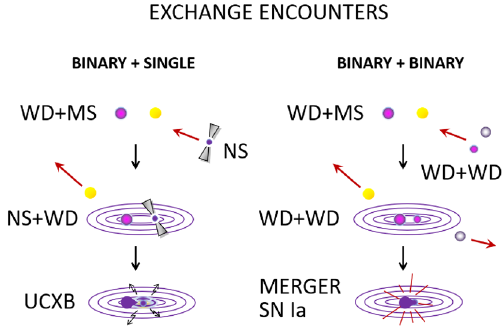
Fig. 10 Illustration of the formation of LISA sources via examples of exchange encounters. See Figs. 6 and 7 for explanation of acronyms. Image reproduced with permission from Tauris and van den Heuvel (2023), copyright by